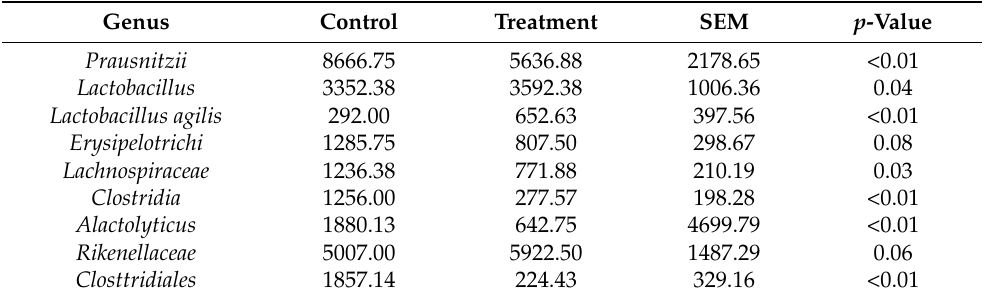
Table 7. Genus level significance analysis of cecal microbial community after 21 days.